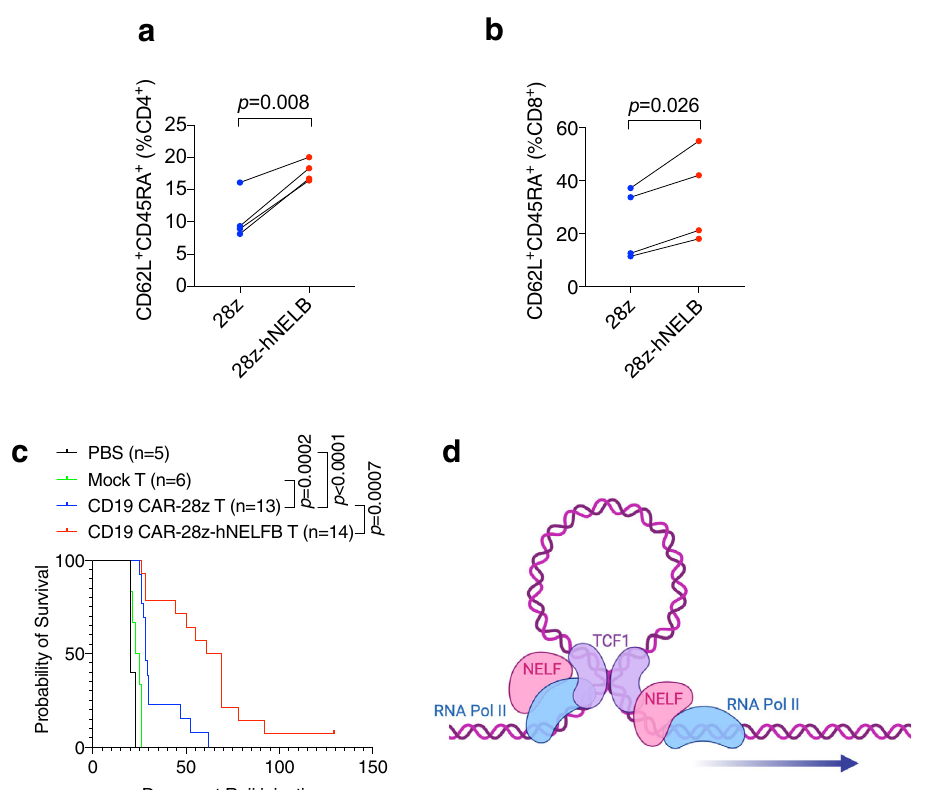
Fig. 8 NELFB overexpression boosts human CAR-T ef fi cacy. a , b Percentages of CD62L + CD45RA + cells within CD4 + ( a ) and CD8 + ( b ) populations of 28z or 28z-hNELFB CAR-T cells after 10 days of in vitro expansion, n = 4/group. c Survival curves of Raji tumor-bearing mice receiving PBS or mock T cells, CD19 CAR-28z T cells, or CD19 CAR-28z-hNELFB T cells. d Model of enhancer – promoter looping mediated by NELFB, Pol II, and TCF1. Mean differences were compared using Student ’ s t -test. Log-rank (Mantel – Cox) tests were used for survival analyses. Source data are provided as a Source Data fi